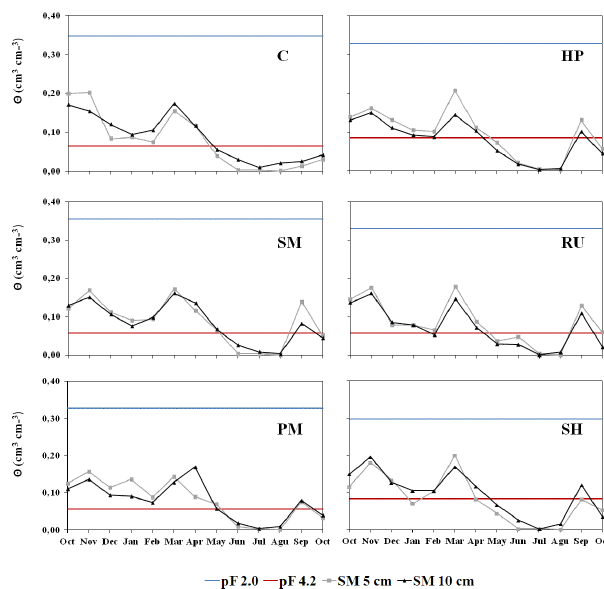
Figure 6. Soil moisture trends under different treatments and their relations to water retention capacity. pF 2.0: field capacity; pF 4.2: wilting point; C: control; SM: straw mulch; PM: chipped branches of Aleppo pine; HP: TerraCottem hydroabsorbent polymers; RU: sewage sludge; SH: sheep